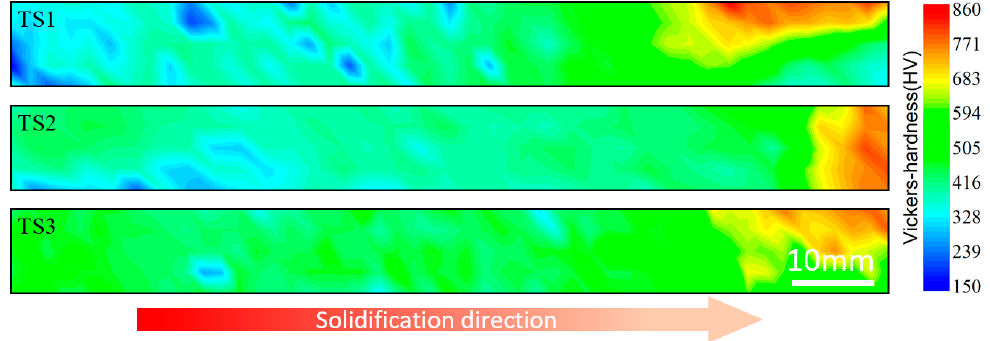
Figure 9. Vickers hardness distribution of TS samples TS1, TS2 and TS3.